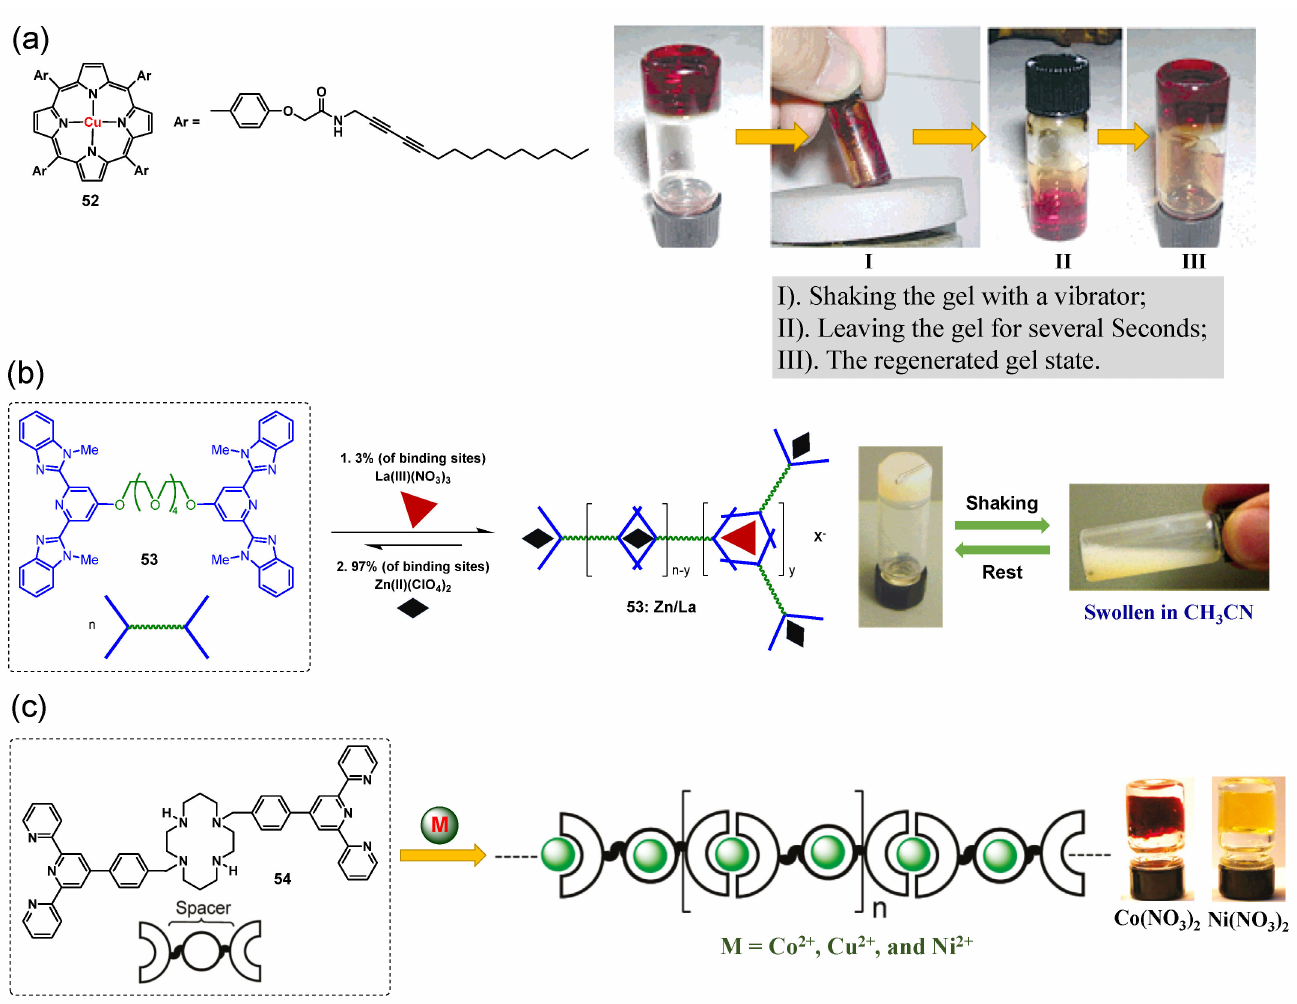
Figure 24. ( a ) Photographs showing the thixotropic behavior of the decalin gel of 52 (( 52 ) = 10 g dm − 3 ). Shaking the gel with a vibrator resulting a gel-to-sol phase transition (I, II). The regenerated gel state after resting (III). Reprinted with permission from Ref. [89]. Copyright (2005), American Chemical Society. ( b ) The mechano-responsive nature of the thixotropic 53 :Zn/La system. Both materials are swollen in acetonitrile (800% by wt.). Reprinted with permission from Ref. [90]. Copyright (2003), American Chemical Society. ( c ) Structure of the ligand 54 and schematic representation of the formation of the metallopolymers. Reprinted with permission from Ref. [73]. Copyright (2009), American Chemical